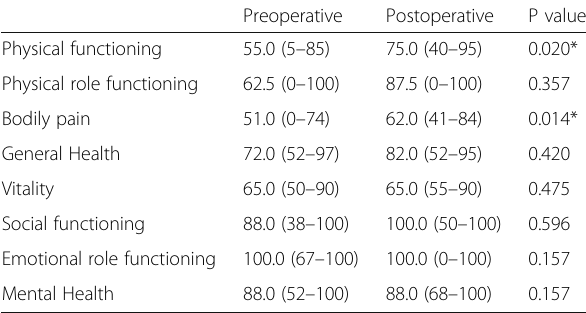
Table 4 Differences in health-related quality of life as measured with the IKDC Current Health Assessment